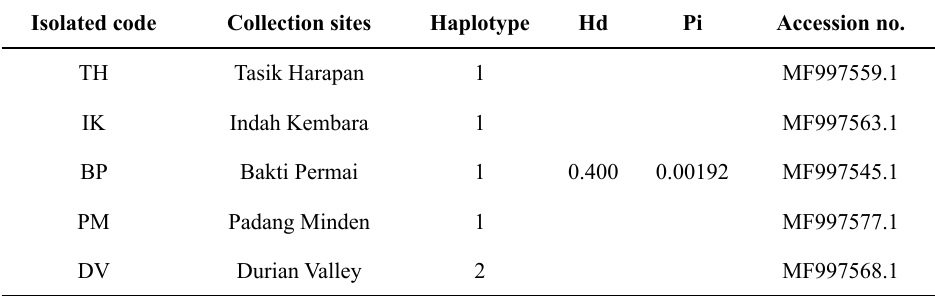
Table 2 . Haplotype, haplotype diversity (Hd), nucleotide diversity (Pi), and accession G. sulphureus from five sample